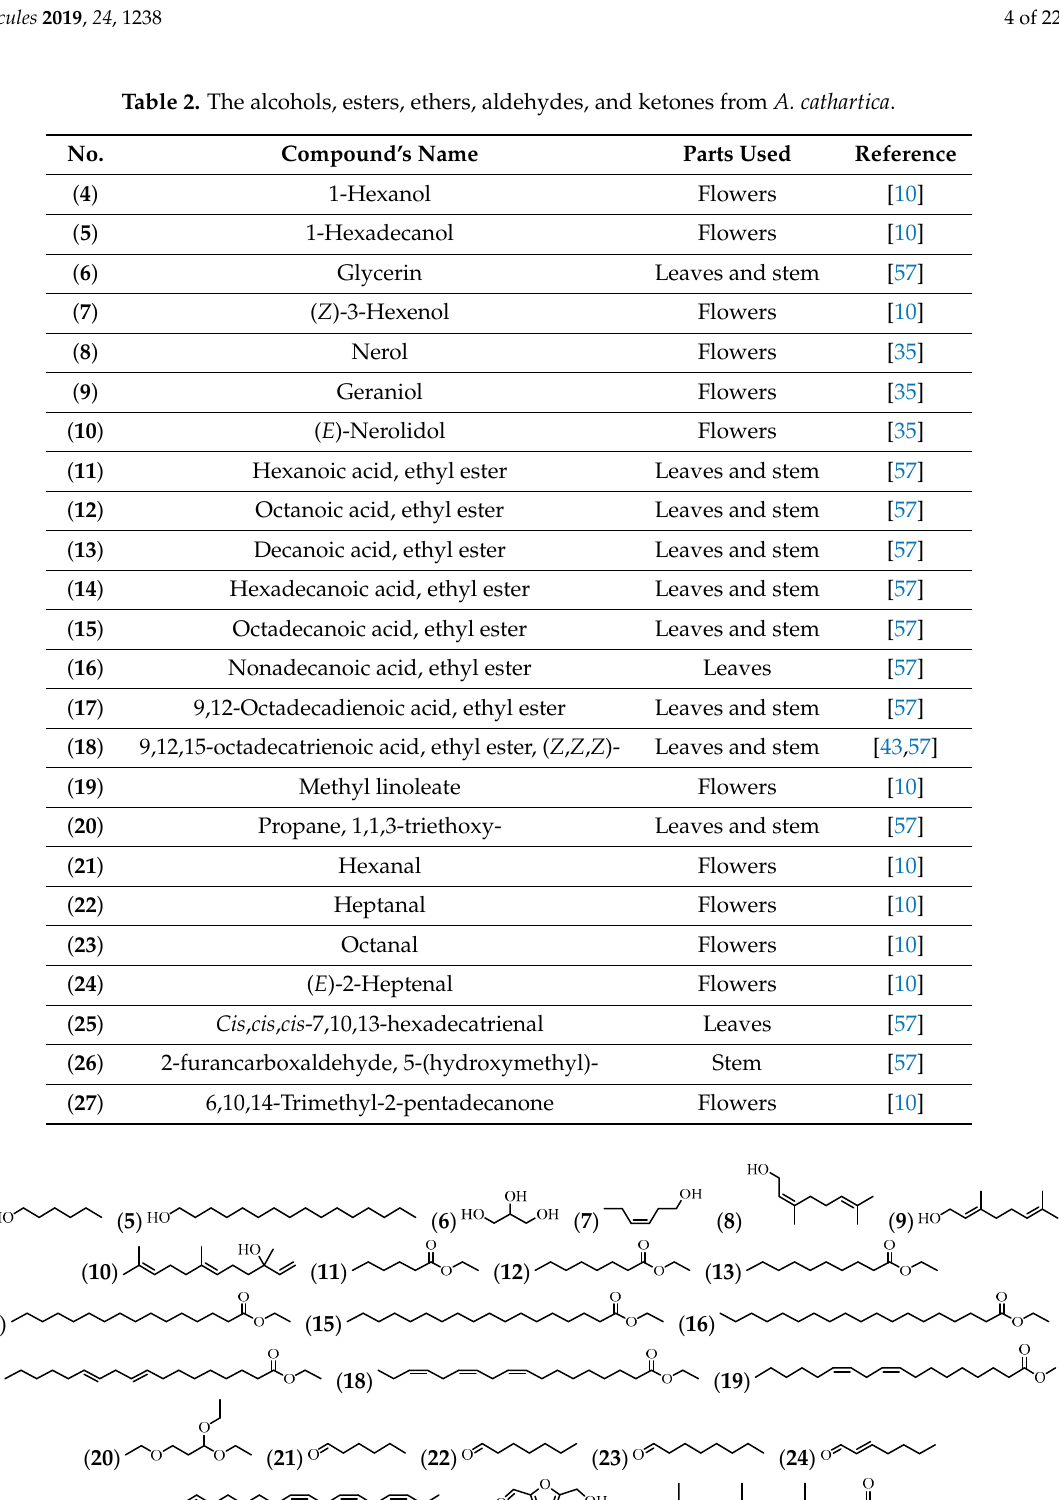
Table 2. The alcohols, esters, ethers, aldehydes, and ketones from A. cathartica . No.